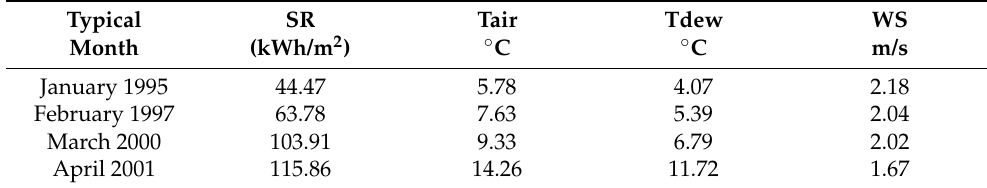
Table 1. Typical meteorological months for the city of Thessaloniki and the corresponding average monthly values of solar radiation (SR), air temperature (Tair), dew point temperature (Tdew) and wind speed (WS) introduced into the Meteonorm weather